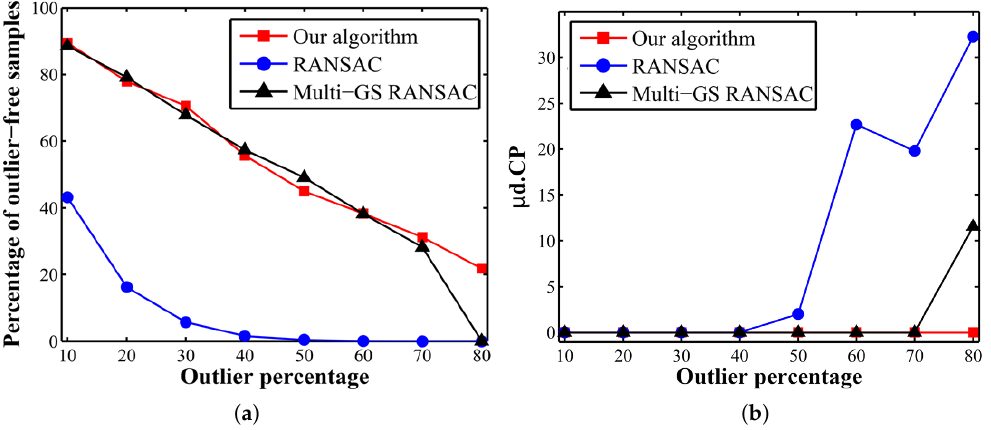
Figure 5. Performance of sampling methods on the Church dataset as the outlier ratio increases: ( a ) percentage of outlier-free sample sets, ( b ) estimation